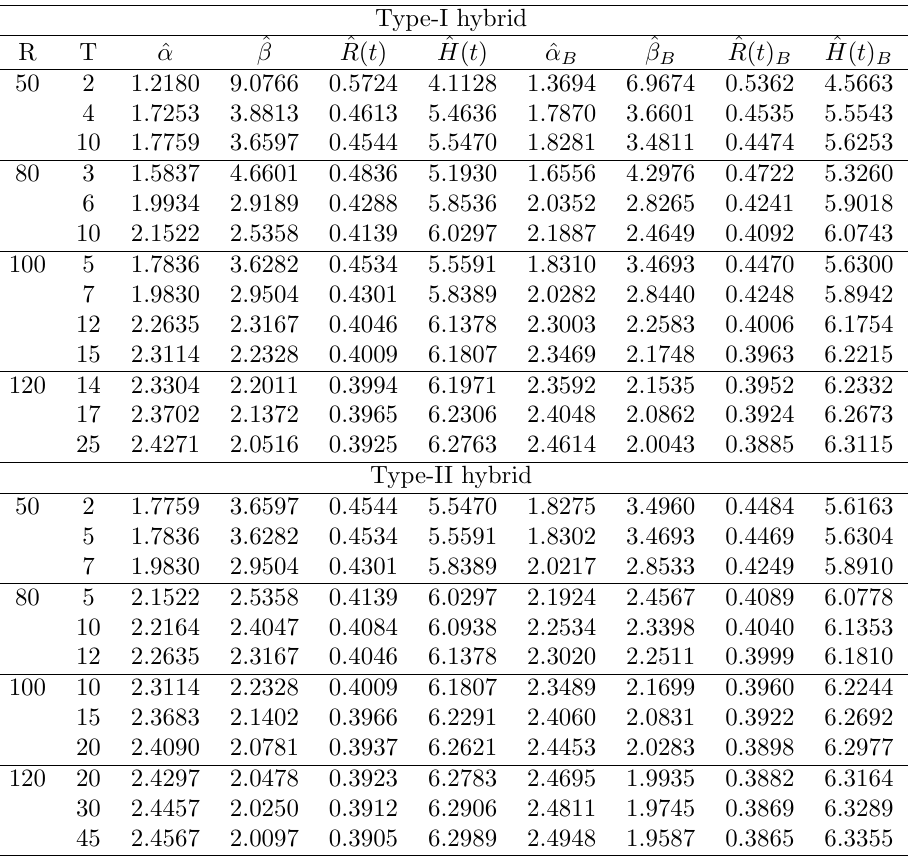
Estimates of the parameters, reliability and hazard functions for different choices of censoring parameters R and T under Type-I hybrid and Type-II